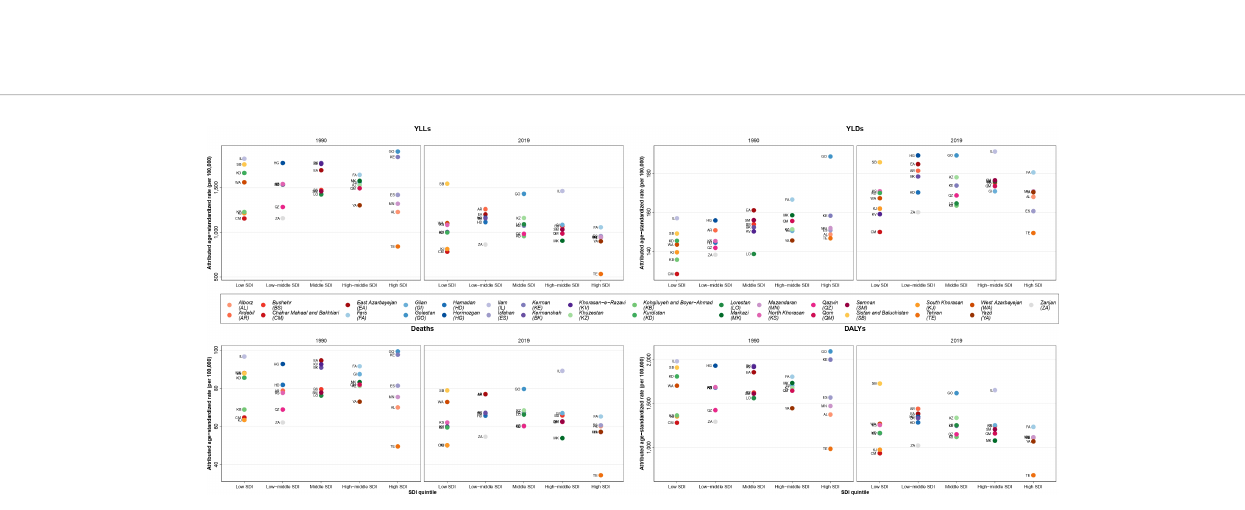
FIGURE 3 Age-standardized rate of years of life lost (YLLs), years lived with disability (YLDs), deaths, and disability-adjusted life years (DALYs) attributable to kidney dysfunction in Iran in 1990 and 2019 by sociodemographic index (SDI) quintiles and